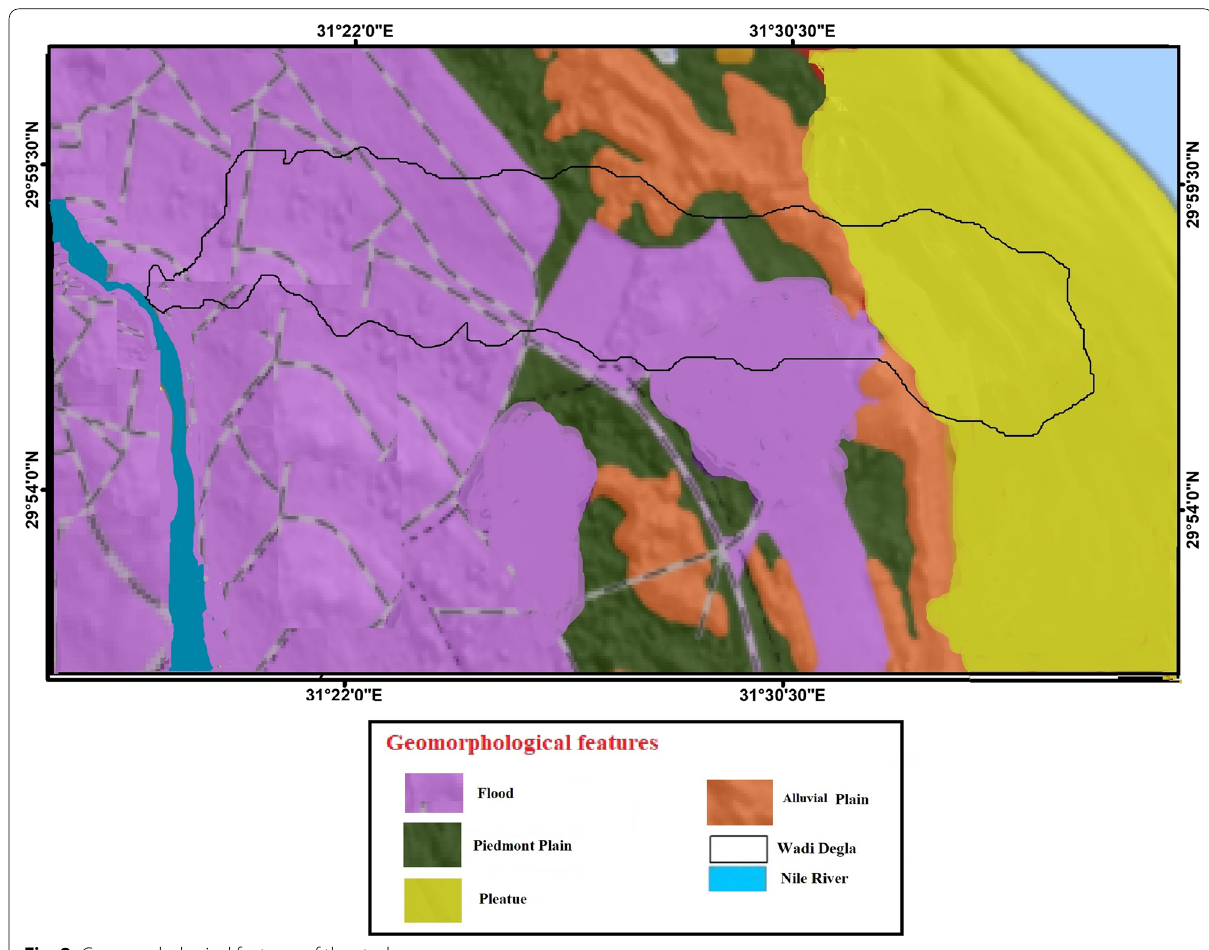
Fig. 2 Geomorphological features of the study